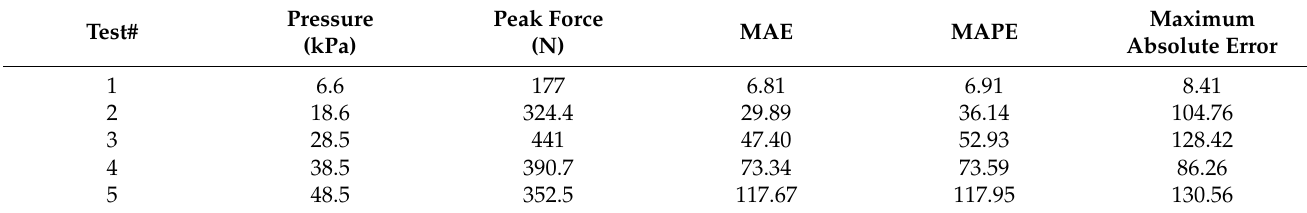
Table 4. Summary of the test data of the PET-beamed actuator.